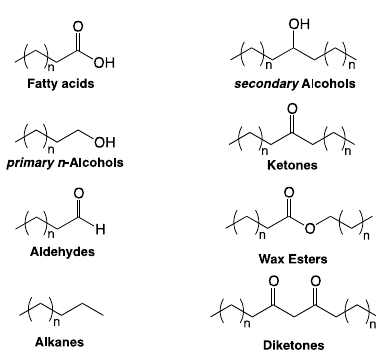
Figure 2. Chemical structures of major cuticular wax compound classes.